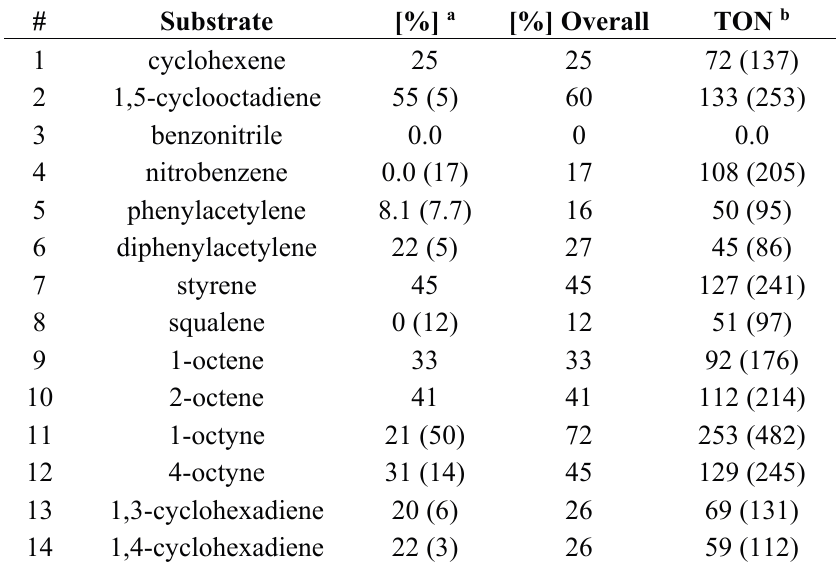
Table 2. Catalyzed transfer hydrogenations with EDAB and Ru@[BMMIM][NTf 2 ] at 70 °C after 18–24